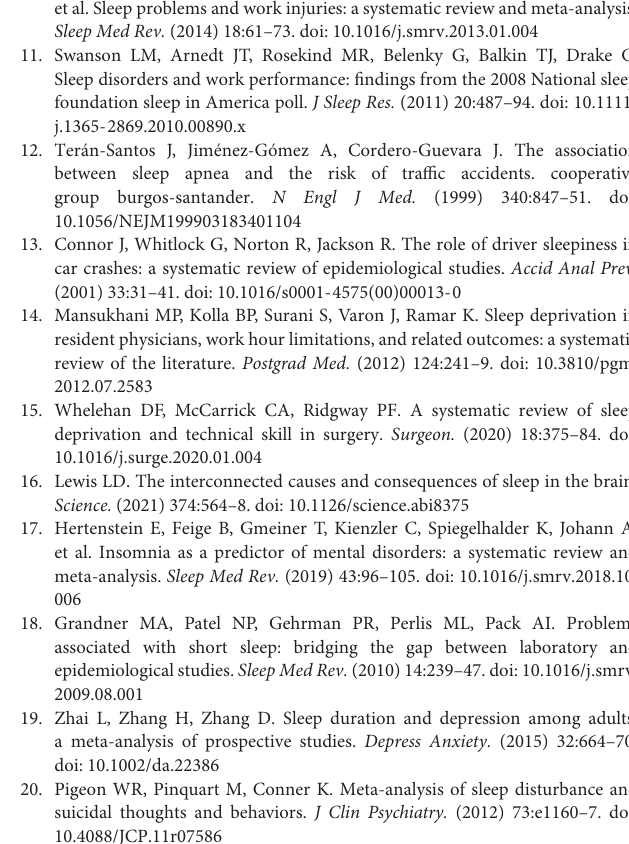
Supplementary Figure 1 | Flow diagram for study